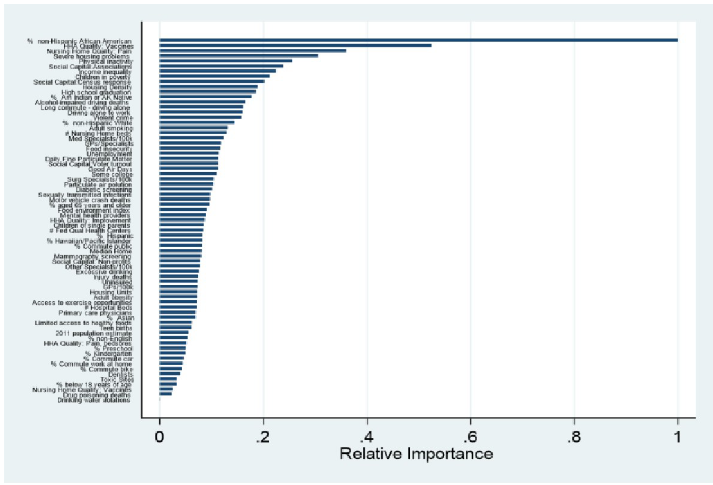
Fig 1. Results of random forest analysis, showing relative importance of each factor for predicting hospital overall Standardized Readmission Ratio (SRR).